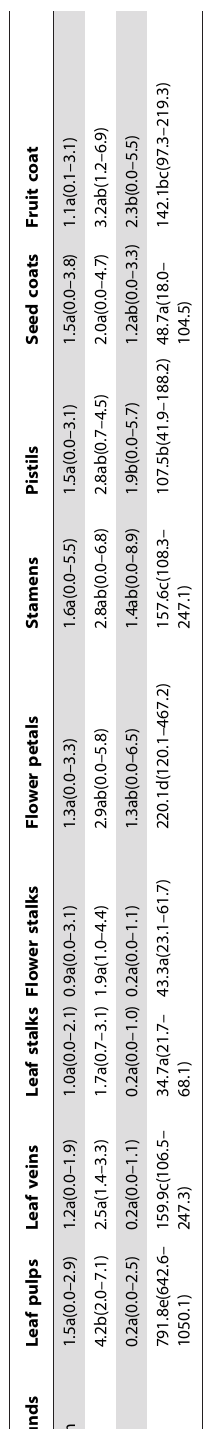
(Table 2). In the leaf and flower stalks of the rhizome cultivar ‘Zhimahuou’, the three quercetin monomers accounted respec- tively for 67.8% and 60.1% of all flavonoids (Fig. 2 C, D). In contrast, aglycone quercetin (24) and Iso-3-Gln (23) concentrations were higher than in leaf pulps and veins (Table 2). Flower petals In lotuses, anthocyanins are found located in the flower petals. The content of flavonoids was seen to be relatively high, ranging from 120.1 to 467.2 mg/100 g FW, significantly higher than in other tissues excluding leaf pulp (Table 2). Flavonoid content in petals strongly depended on genetic background. The yellow petal cultivars ‘Jingque’ (459.1 mg/100 g FW) and ‘Mingmei’ (467.2 mg/100 g FW) of N. lutea had the highest total flavonoids, significantly higher than all cultivars of N . nucifera . Within N . nucifera , a relatively high flavonoid content was found in ‘Honglian’, ‘Zhuguang’, ‘Zhimahuou’, ‘Xianglian’ and ‘Ti-3’, with concentrations between 200 and 300 mg/100 g FW. The